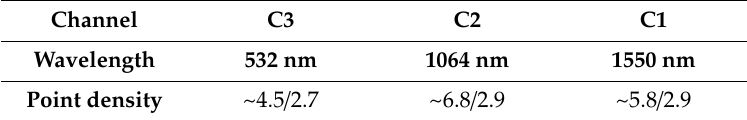
Table 2. Point density per m − 2 of forest covered compared to open area (second value) for one flight line averaged over 11.3 m radii plot areas for each channel.